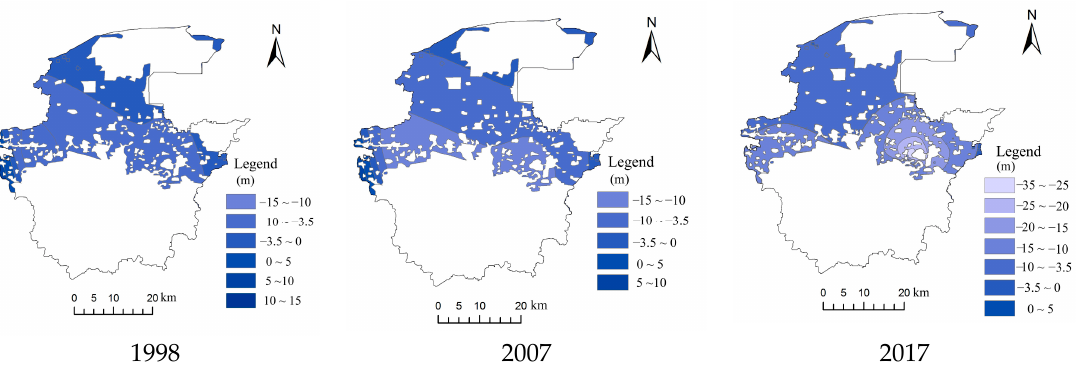
Figure 7. Groundwater level distribution in northern Shouguang in 1998, 2007, and 2017.